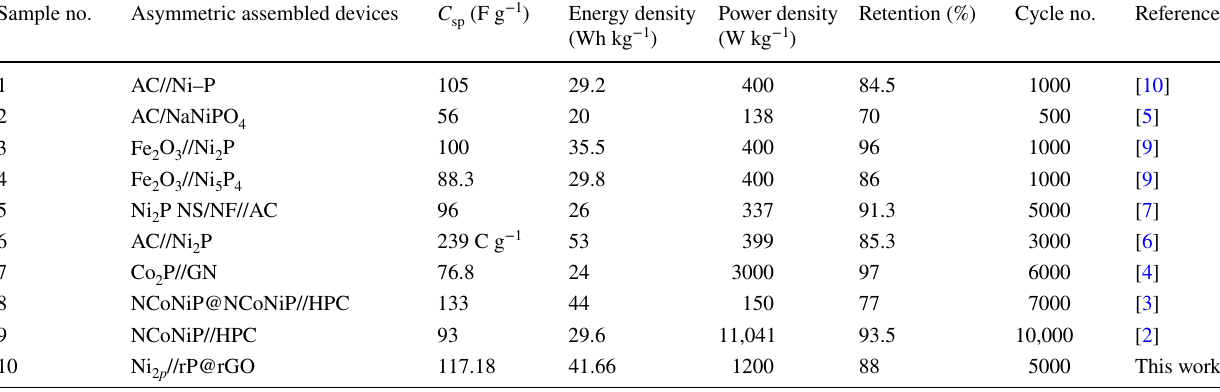
Table 1 Performance comparison of the Ni 2 P//rP@rGO asymmetric supercapacitor device with data from the previously published studies Sample